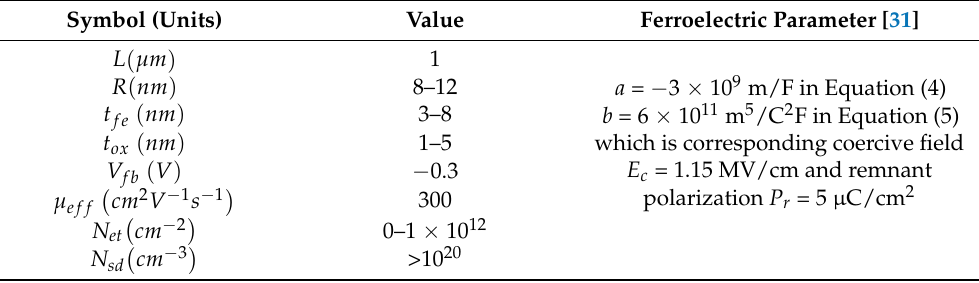
Table 1. Parameter symbols and